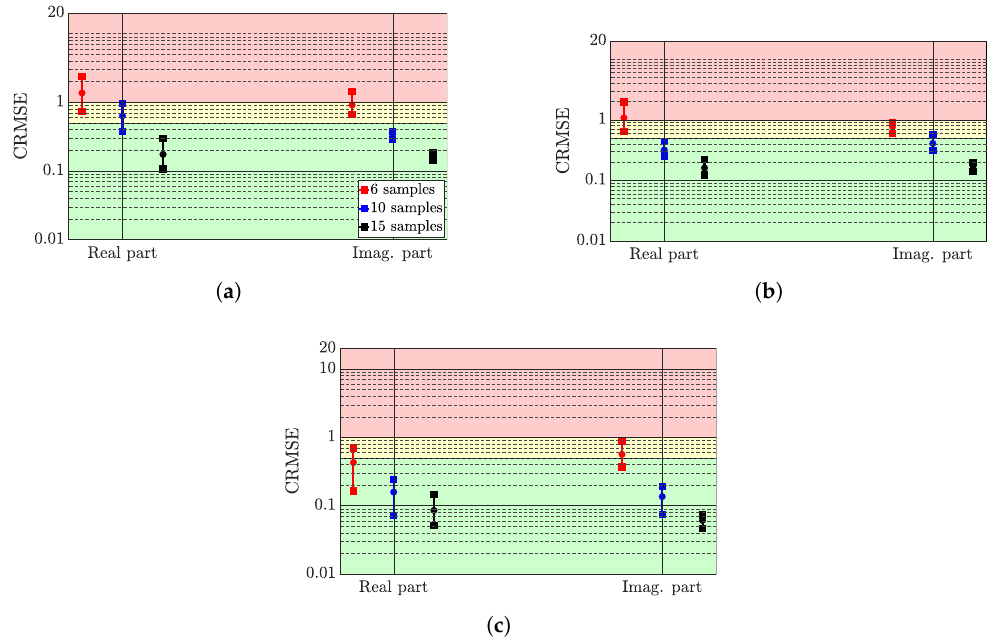
Figure 7. CRMSE range of variations for the best hyperparameter setting of the three considered surrogate models. ( a ) Gaussian process, ( b ) deep Gaussian process, ( c ) deep neural